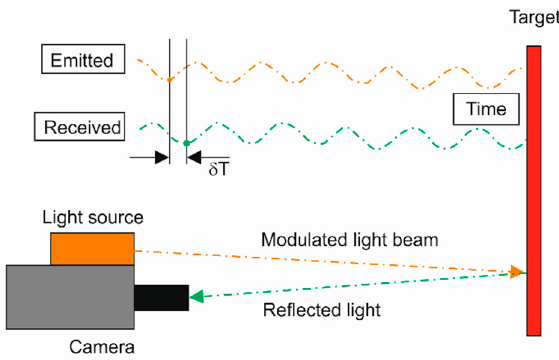
Figure 3. Operating scheme of time of flight (ToF) systems.